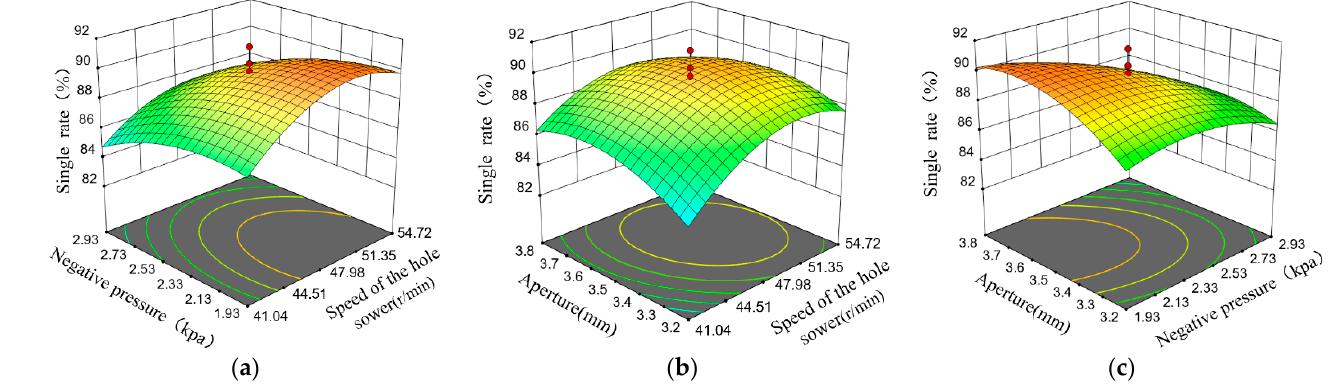
Figure 17. Effect of interaction factors on single grain rate. ( a ) Effect of hole sower speed and negative pressure on seed rate; ( b ) Effect of hole sower speed and aperture size on seed rate; ( c ) Effect of negative pressure and aperture size on the seed rate.